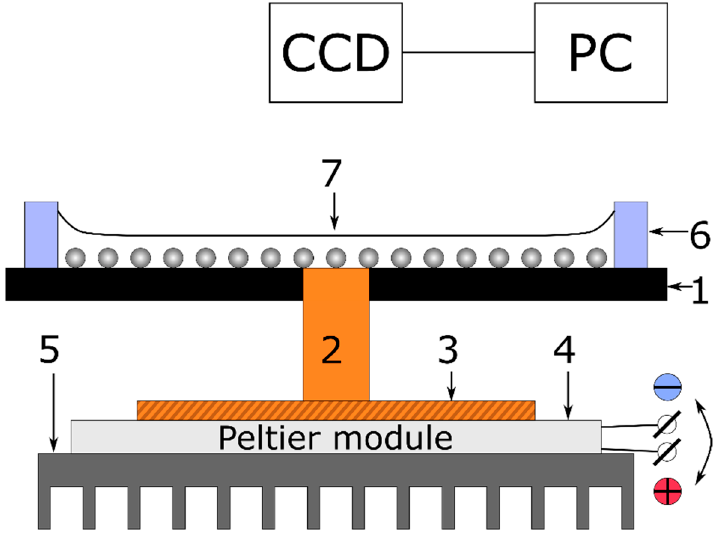
Figure 1. Sketch of the experimental setup for studying the formation of the ring-shaped deposit: 1—glass substrate, 2—copper rod, 3—copper plate, 4—Peltier module, 5—aluminum radiator, 6—polymeric ring, wall of the fluidic cell, 7—polystyrene particles on the substrate covered with a liquid layer.